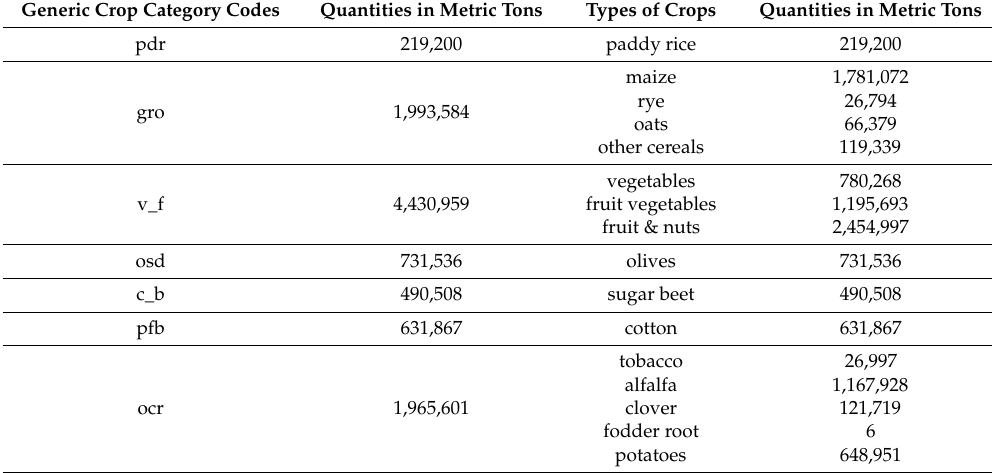
Table 1. Crop category codes used in MAGNET, types of crops included under each category and the corresponding quantities in 2011, used as input to